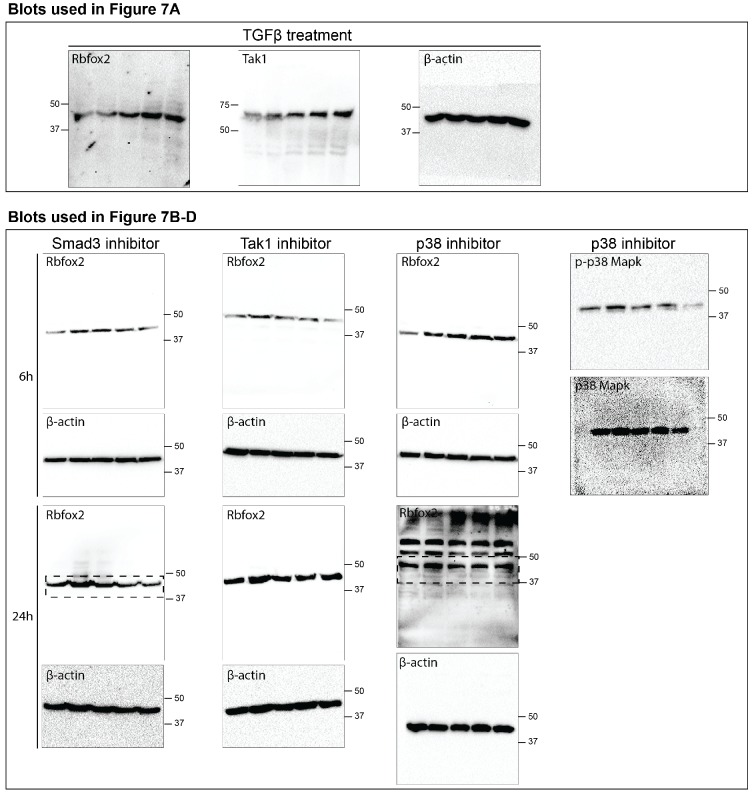
Rbfox2 expression is regulated by TGFβ signaling pathway.Uncropped western blot images presented in Figure 7 of this manuscript. Dotted box indicates areas that were cropped for use in figures when multiple bands observed.